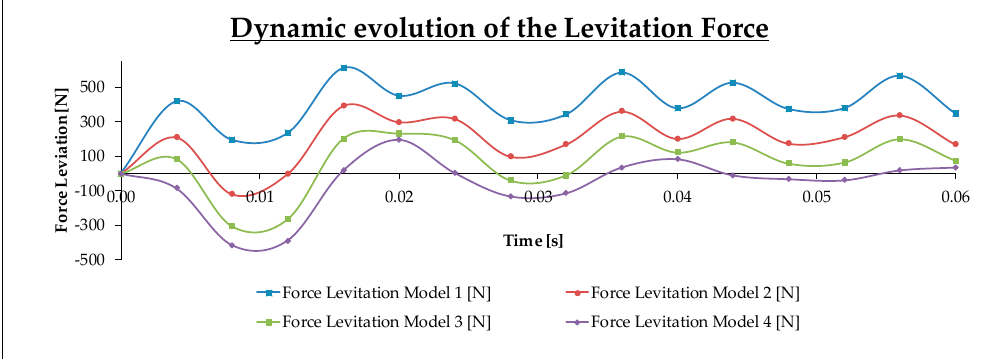
Figure 27. Dynamic evolution of the levitation force in each model.